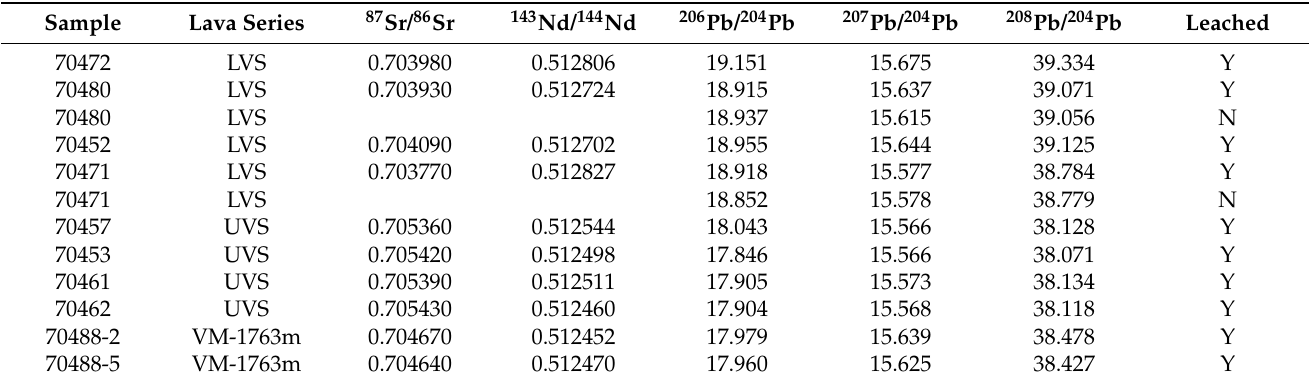
Table 2. Sr, Nd and Pb isotopic composition of volcanic rocks from Christmas Island and dredged by the RV Franklin voyage FR9_87.